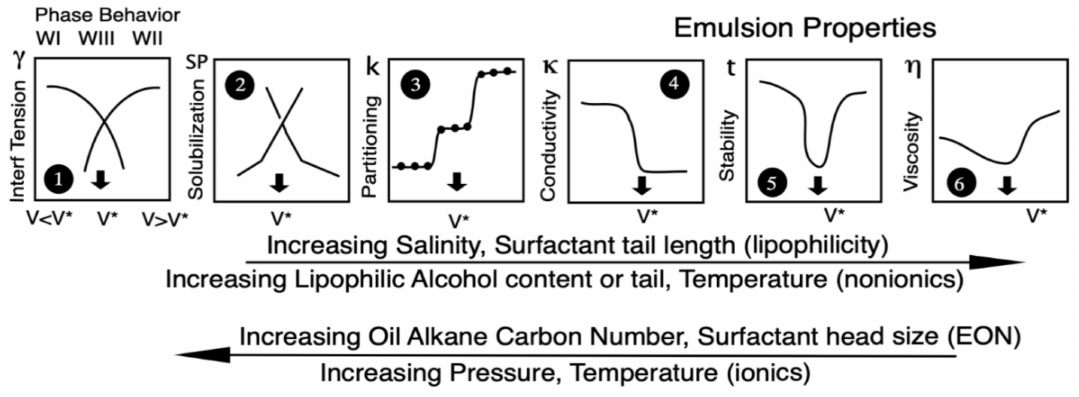
Figure 7. Di ff erent occurrences taking place at the optimum value (V*) of a single variable scan, whichever the formulation variable